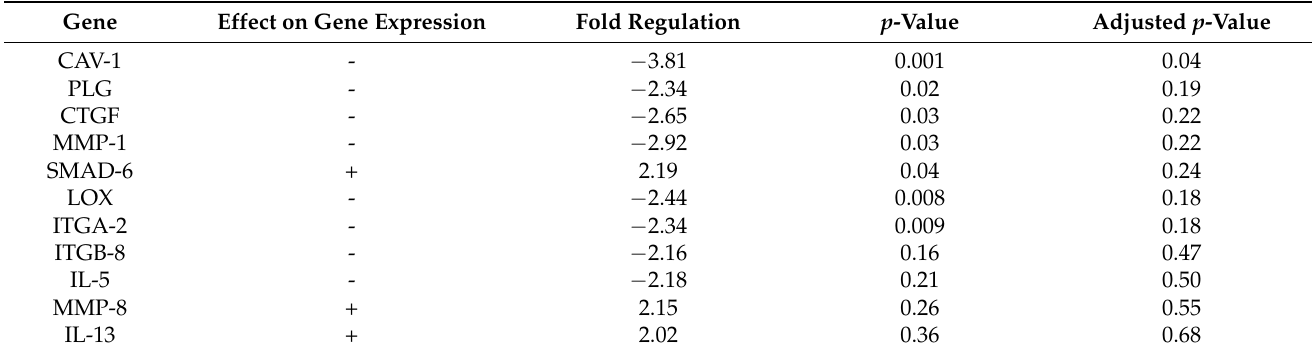
Table 2. Gene expression patterns in patients with chronic hepatitis C and controls. P-values are corrected for multiple testing with Benjamini–Hochberg method.